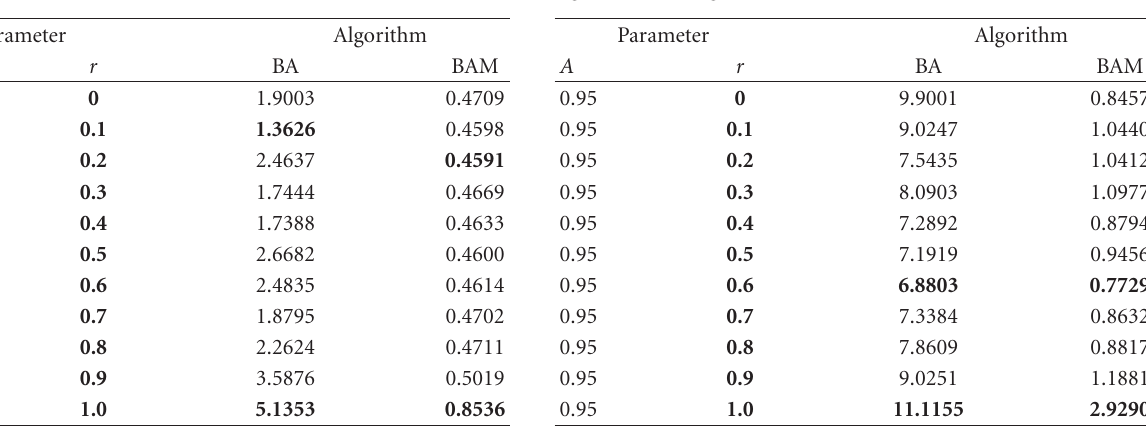
Table 14: Best normalized optimization results on UCAV path planning problem on di ff erent r . The numbers shown are the best results found after 100 Monte Carlo simulations of BA and BAM algorithms.